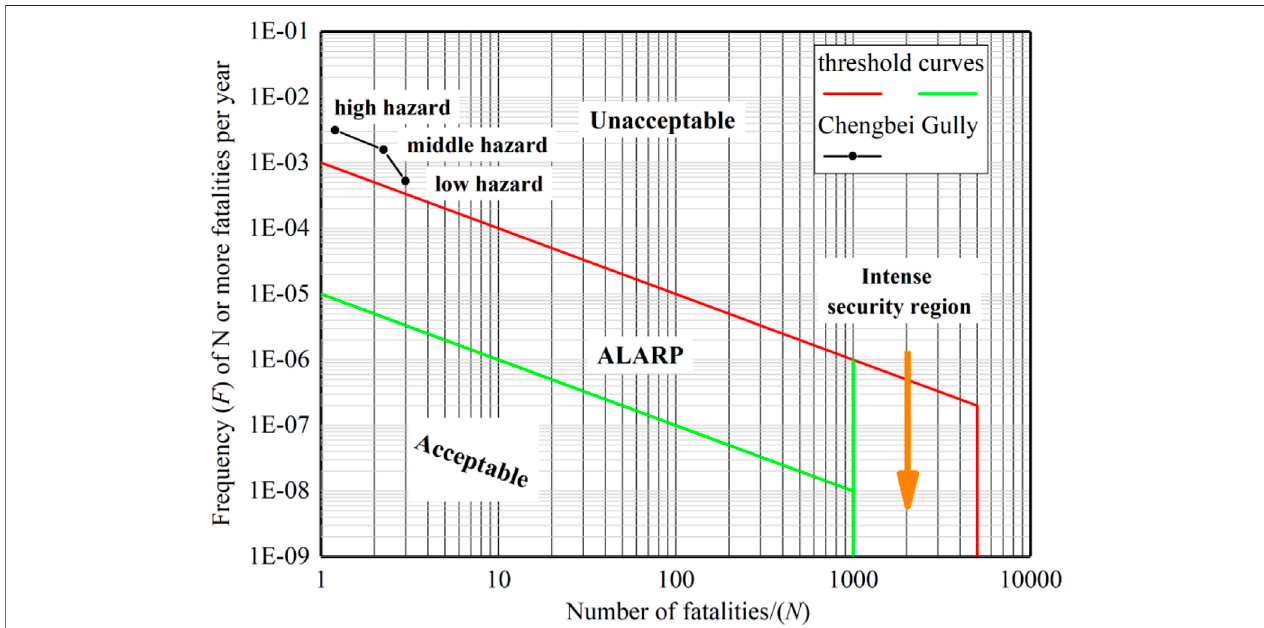
FIGURE 13 | Calculation of the risk level for the Chengbei Gully debris fl ow using the risk tolerance criteria.